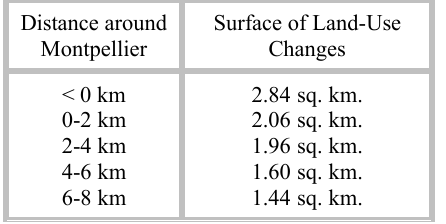
Table 1. Surface of land-use changes between 2006 and 2012 according to the distance around the city of Montpellier (France)